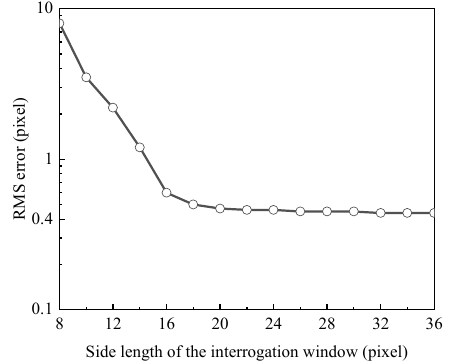
Figure 8. Root Mean Square (RMS) error as function of the interrogation window size.